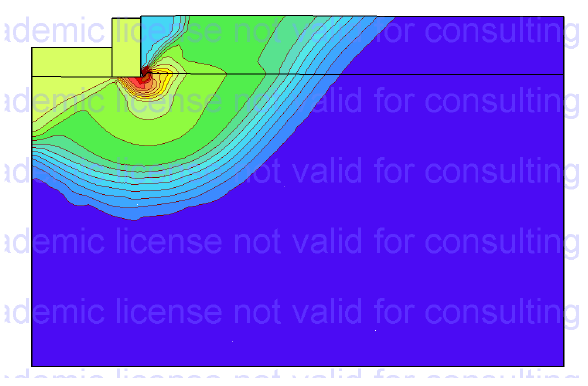
Figure 8: 2D numerical model of the bench and slab with boundary conditions.